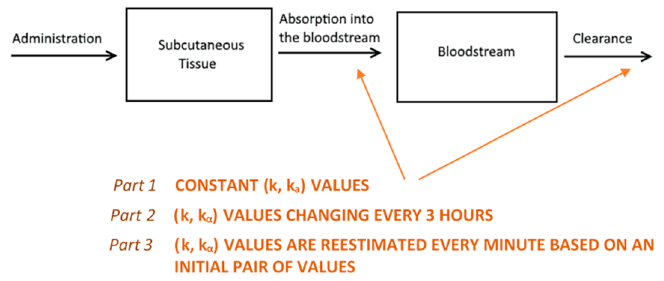
Figure 7. An illustration of the reasoning behind the two-compartment model. Hydrocortisone (HC) is administered into the subcutaneous tissue where it is absorbed with a rate of k α . Then, it is distributed via the bloodstream throughout the body, where it is cleared (by the liver and kidneys) with a rate k as predicted by the model. Initially, we assumed that both absorption and clearance rates were constant (part 1) and demonstrated why this is an unrealistic assumption. Following this, we proceeded to estimate a different ordered pair ( k , k α ) for every three-hour interval. Then, we concatenated the eight curves together to create a graph for a full day (part 2). Finally, we assumed that both rates change every minute (part 3), with the absorption rate depending on the magnitude of the dose administered and clearance rate depending on circulating cortisol levels.